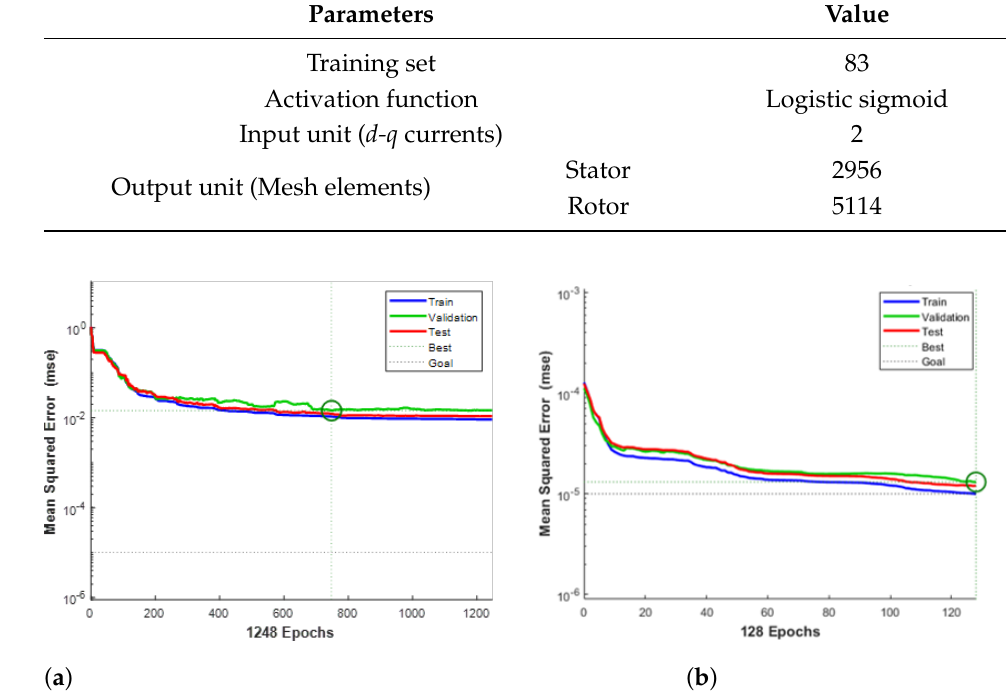
Figure 11. Example of learning performance: ( a ) stator. ( b ) rotor.